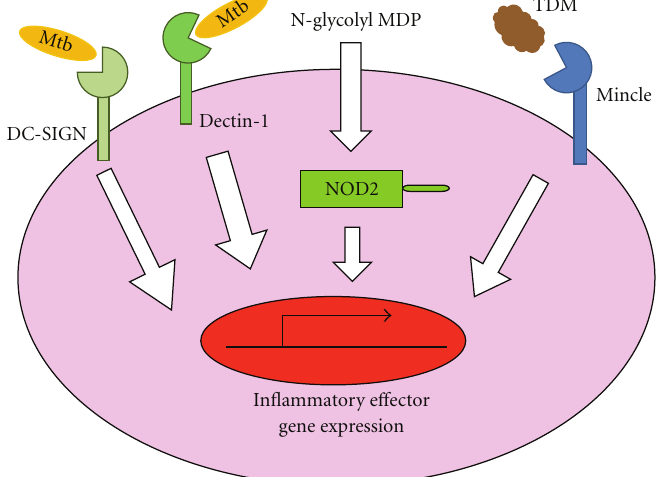
Figure 2: Recognition of mycobacteria by pattern recognition receptors. Several pattern recognition receptors, such as NOD-like receptors and C-type lectin receptors, mediate the TLR-independent recognition of mycobacteria. NOD2, a member of NOD-like receptors, recognizes mycobacterial N-glycolyl MDP within the cytoplasm. DC-SIGN and dectin-1 are members of C-type lectin receptors, which are implicated in the recognition of mycobacteria. In addition, Mincle has been shown to recognize TDM (a mycobacterial cell wall